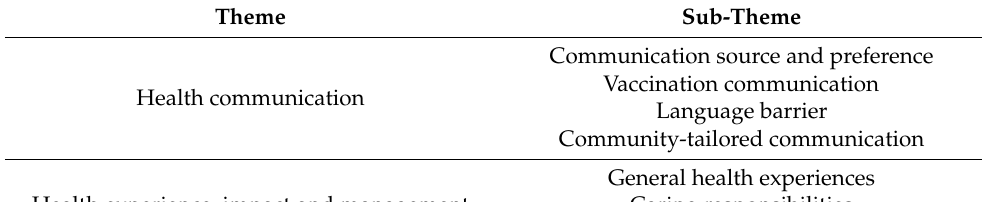
Figure 1. Word cloud of 100 most commonly used words by study participants. Table 1. Summary of identified themes and subthemes.